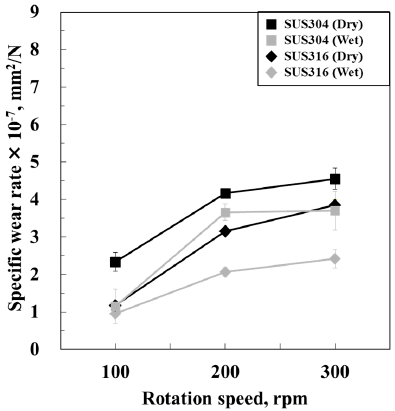
Figure 2. W s of test blocks against HSS rings obtained from wear tests under dry and wet conditions.